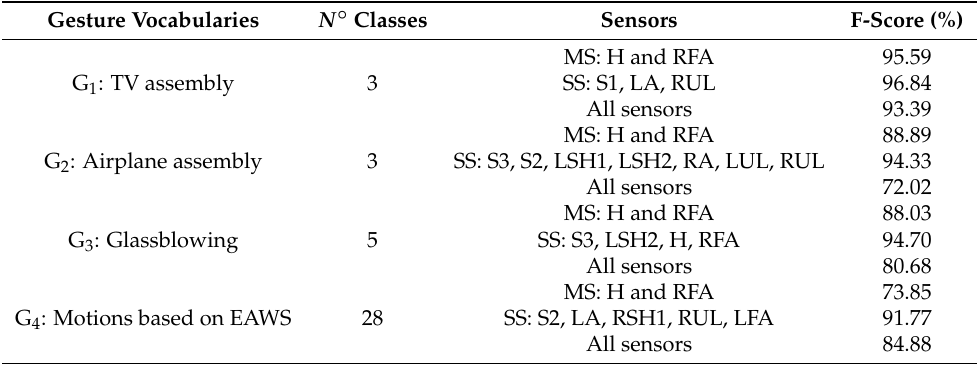
Table 5. Recognition performance with each configuration of sensors. MS: Minimal set of two sensors. SS: Selected sensors by using the GOM.